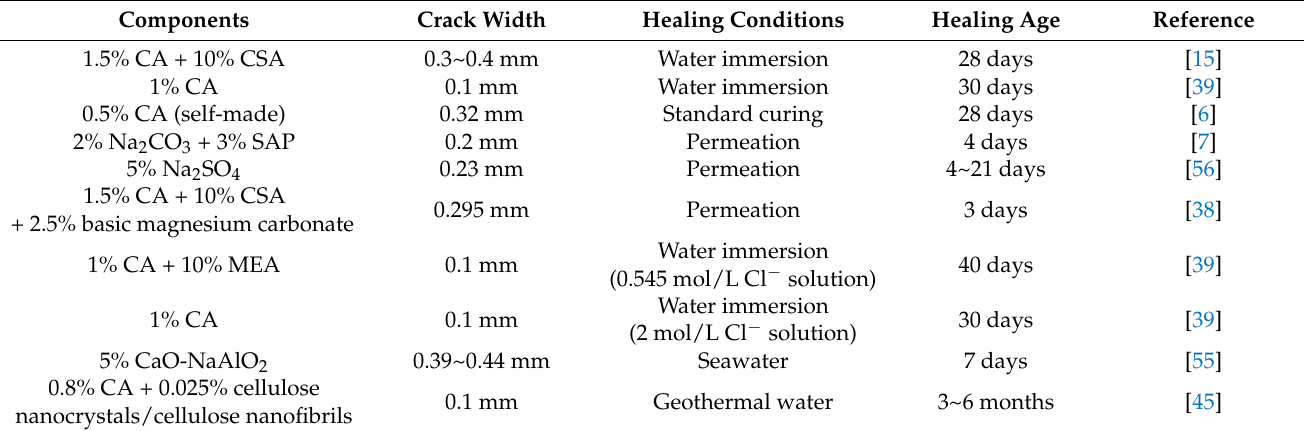
Table 7. Complete healing of cracks or complete cessation of